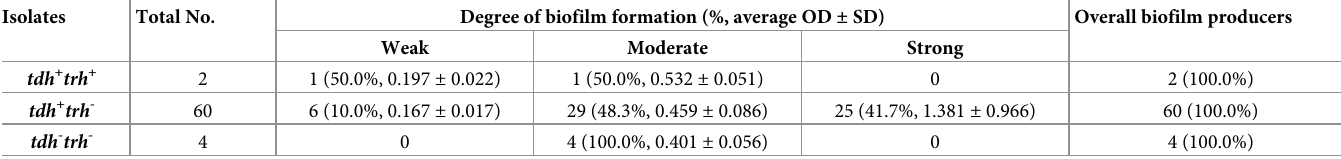
Table 3. Biofilm formation by V . parahaemolyticus isolates at 30˚C. Isolates Total No.